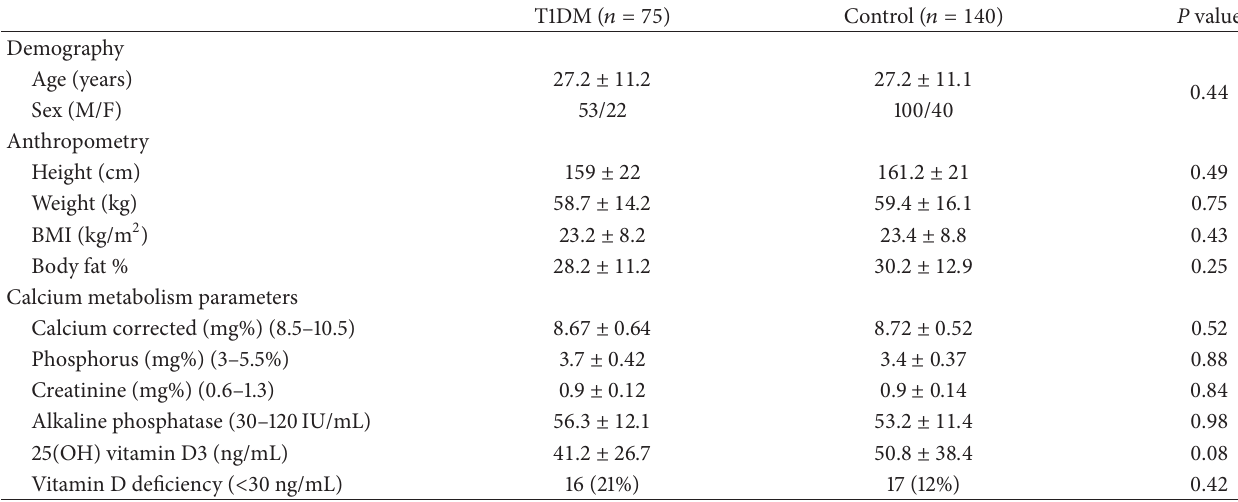
Table 2: Comparison between T1DM patients and age and sex matched controls (demography and calcium metabolism parameters) (expressed as mean ± SD).